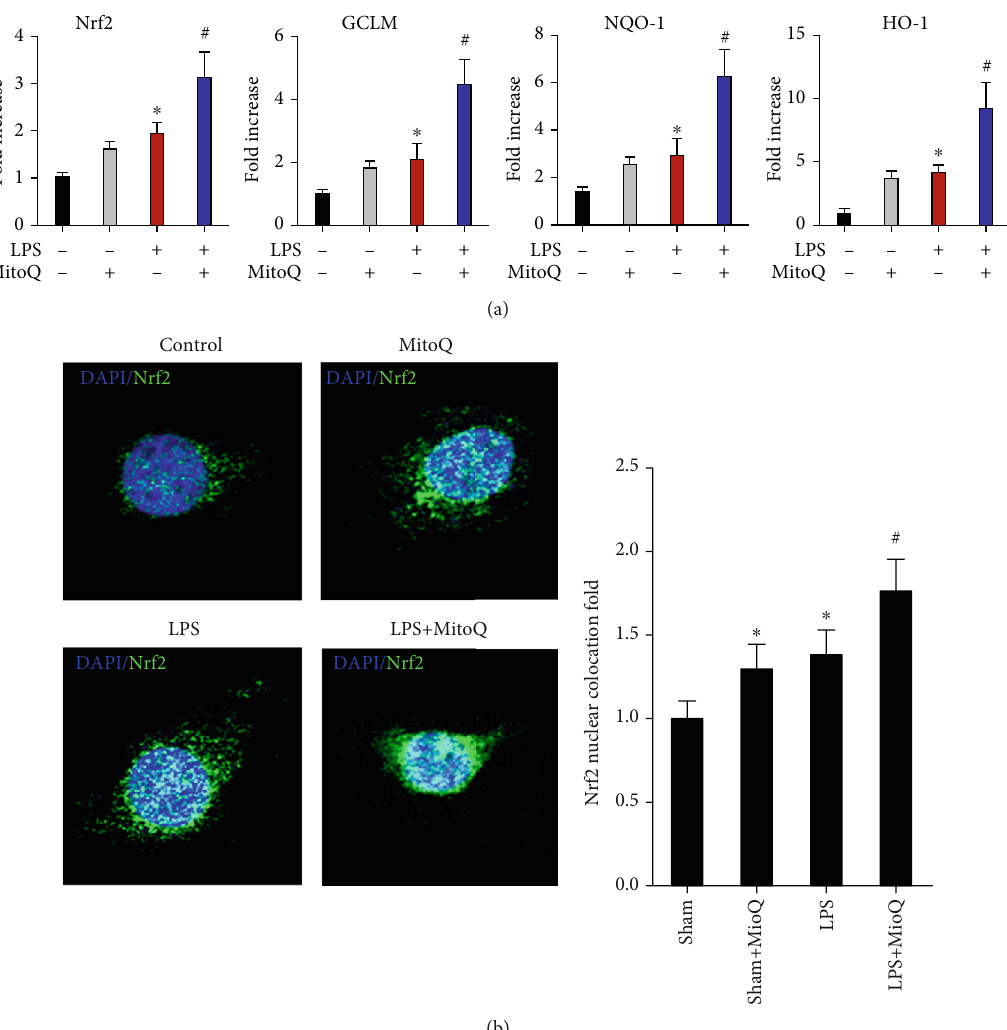
Figure 6: MitoQ alleviates LPS-induced oxidative stress via Nrf2 signaling. (a) qPCR analysis of total Nrf2, GCLM, NQO-1, and HO-1 among four groups. Immuno fl uorescence staining showing changes in Nrf2 fl uorescence (b). MitoQ increases nuclear translocation of Nrf2 (endogenous) in LPS-treated IEC-6